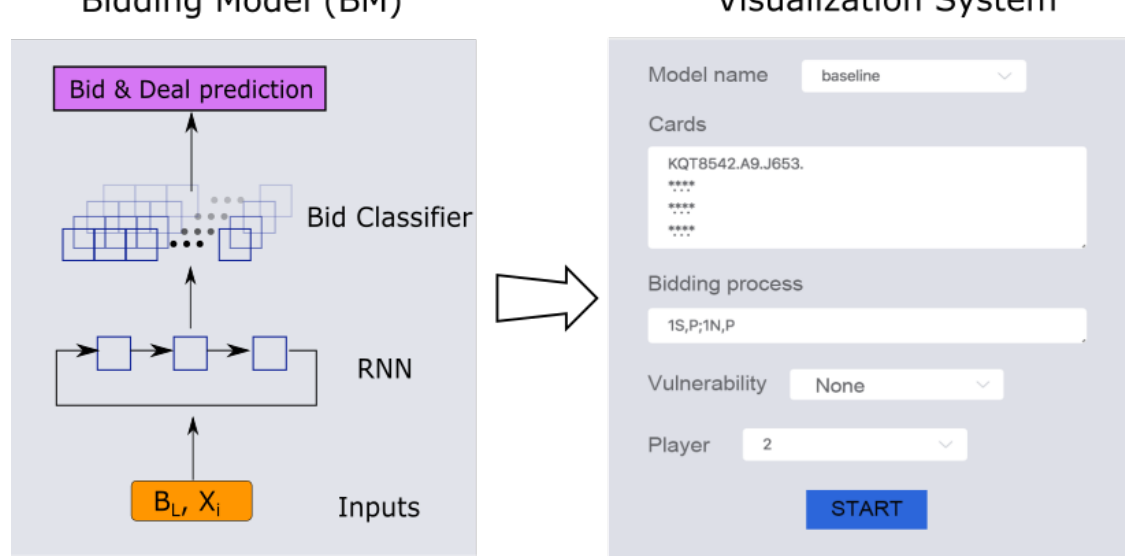
Figure 1. An overview of the proposed framework. It includes two parts: the bidding model and the visualization